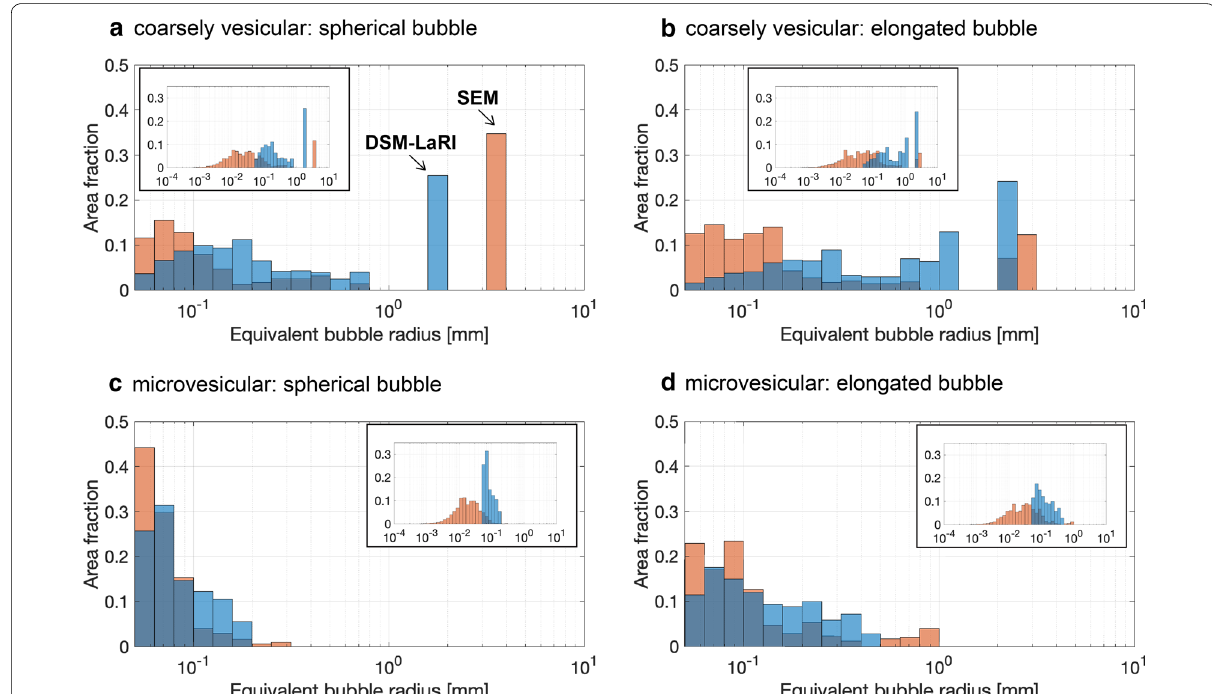
Fig. 5 Histograms of equivalent bubble radius. Histograms of equivalent bubble radius ( R ) versus area fraction obtained with the DSM-LaRI (blue) and the SEM (red). The mainframes include only bubbles of R > 0.05 mm , while the inset graphs show the area fraction distribution of all the bubbles captured by the SEM. a Sample 08_07. b Sample 08_18. c Sample 10_26. d Sample